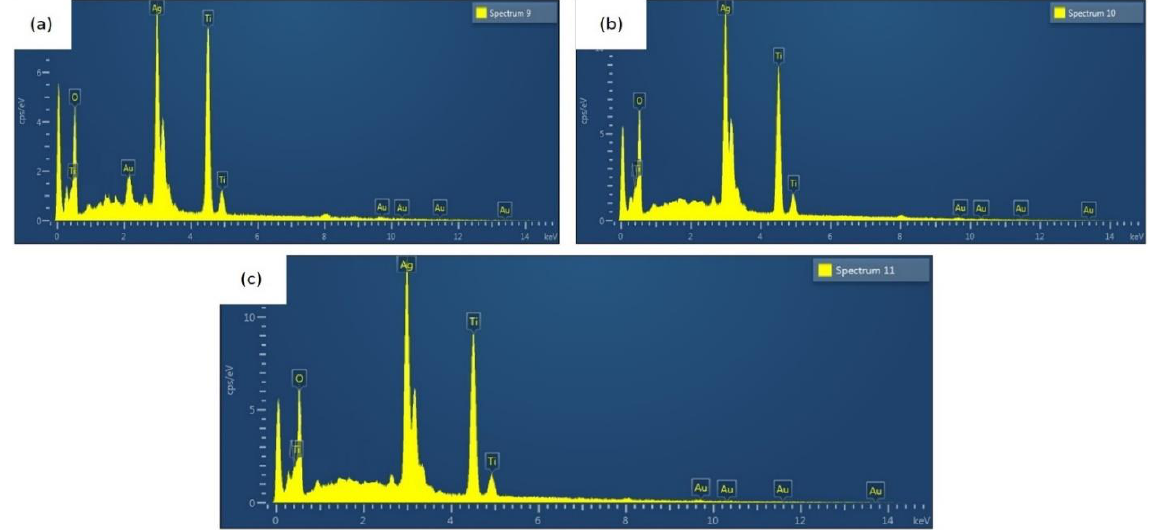
Figure 5. ( a ) EDS of 0.5 Ag/TiO 2 composite. ( b ) EDS of 0.01 Ag/TiO 2 composite. ( c ) EDS of 0.1 Ag/TiO 2 composite. Table 1. The elemental composition of ( a ) 0.5 Ag/TiO 2 composite; ( b ) 0.01 Ag/TiO 2 composite; ( c ) 0.1Ag/TiO 2 composite.